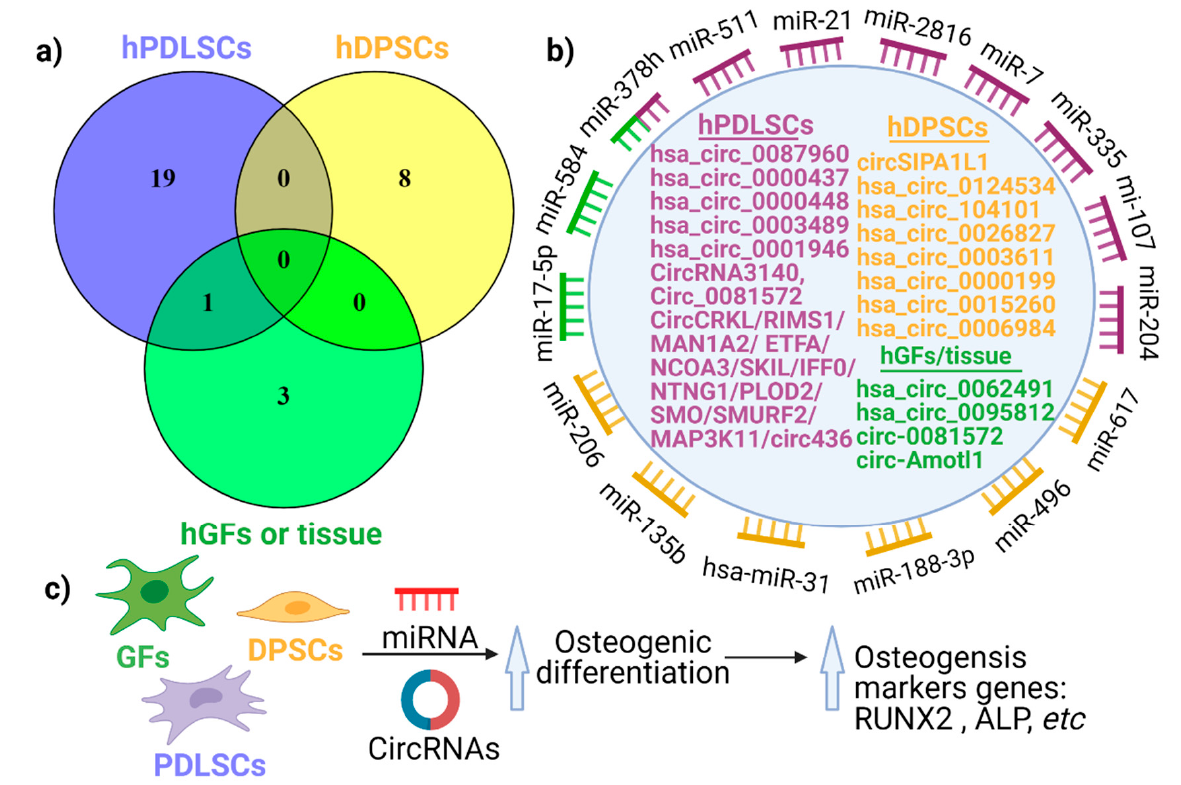
Figure 3. Cell-specific expression of circRNAs ( a ), the potential role of circRNAs as a miRNA sponge ( b ) and the circRNA- miRNA network ( c ) during osteogenic differentiation. ( a ) A Venn diagram showing the expression pattern of circRNAs in hPDLSCs, hDPSCs and hGFs (or tissue). ( b ) The function of circRNAs when they act as miRNAs sponges. ( c ) The mechanism of circRNAs in osteogenic differentiation for hPDLSCs, hGFs, and hDPSCs exerted via a circRNA-miRNA network.